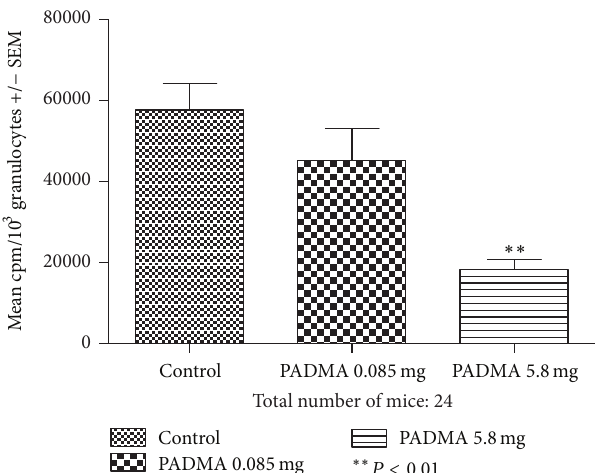
Figure 2: Effect of PADMA 28 (0.085 or 5.8 mg) supplementation on chemiluminescent activity of mouse granulocytes. Balb/c mice were fed daily per os with 0.085 mg or 5.8 mg of PADMA 28. After 7 days mice were bled and sacrificed. The chemiluminescence was measured with luminol after activating with blood with zymosan, in scintillation counter (RackBeta 1218, LKB, Sweden). Results are presented as the mean cpm +/− standard error (SEM) per 1000 granulocytes. ∗∗ 𝑃 < 0.01 .